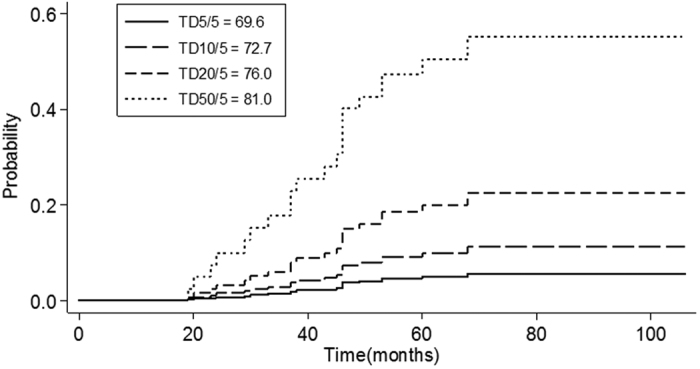
Failure functions adjusted to Dmax using a univariate Cox model (n = 264) are shown.The failure functions adjusted to D1cc were similar and omitted.